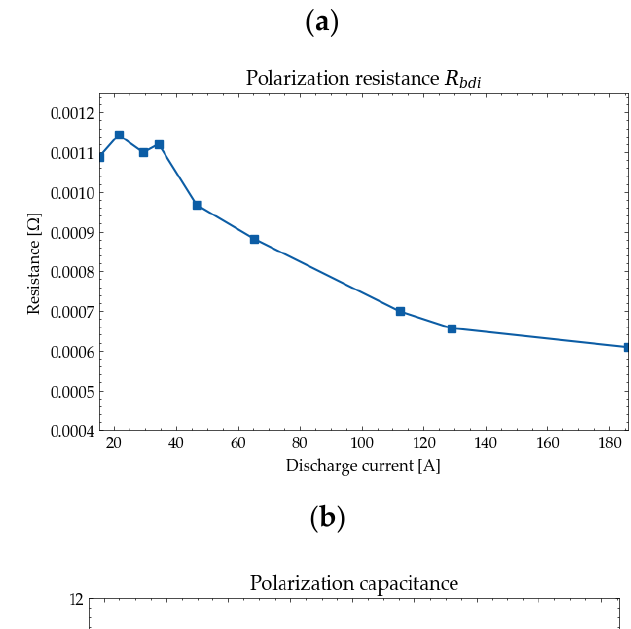
resistance R sd, ( b ) polarization capacitance C ov and ( c ) polarization resistance R bdi.